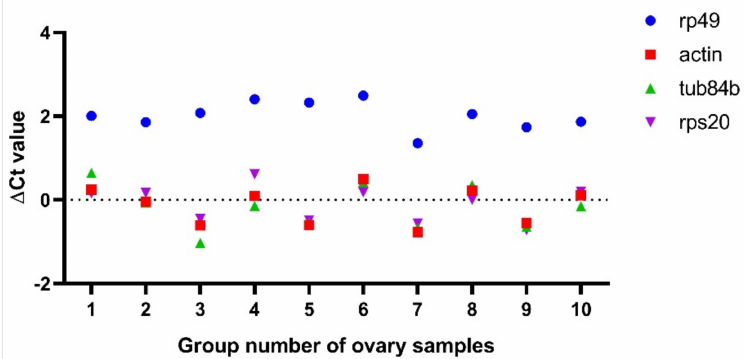
Figure 5. Rp49 decreased expression in fkbp39 mutant ovaries. The ∆ Ct values of the indicated genes between wild type and fkbp39 1 were detected by